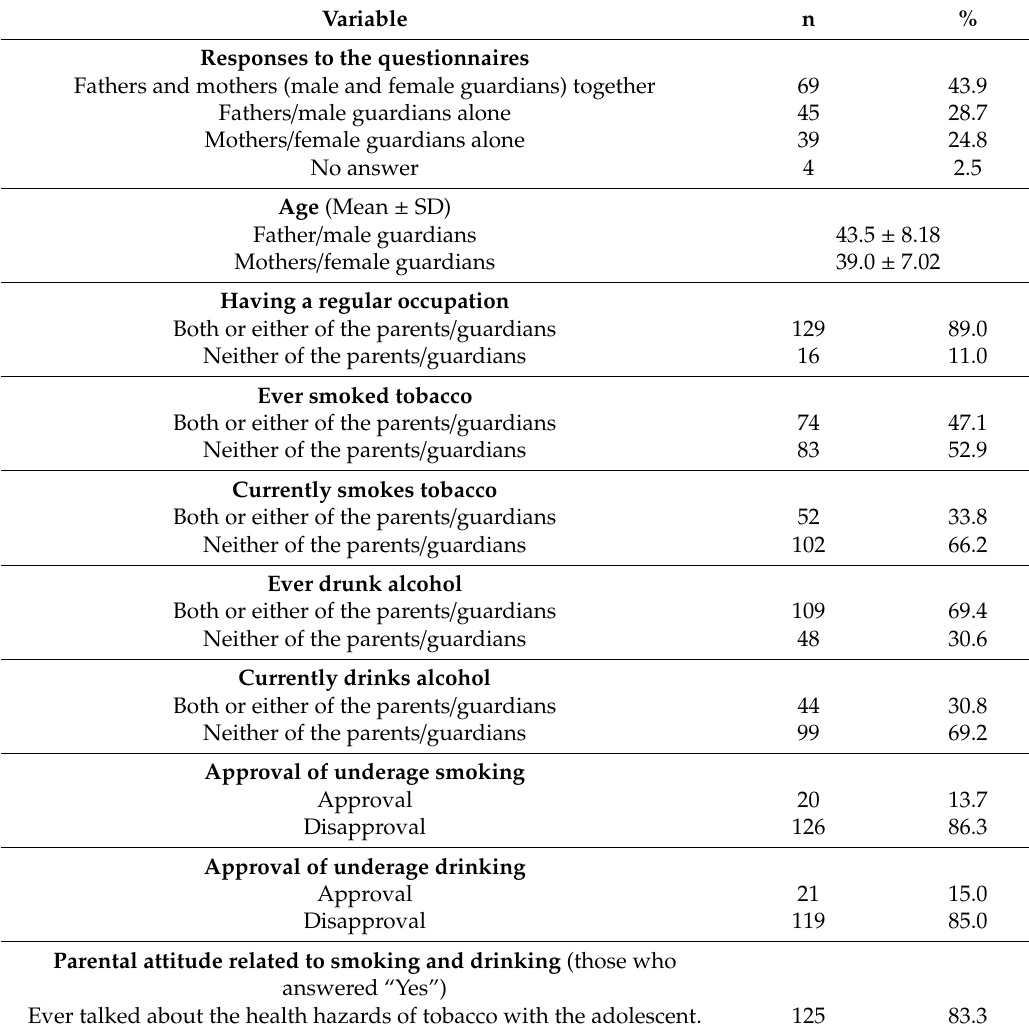
Table 2. Characteristics of the sample of parents / guardians (n =